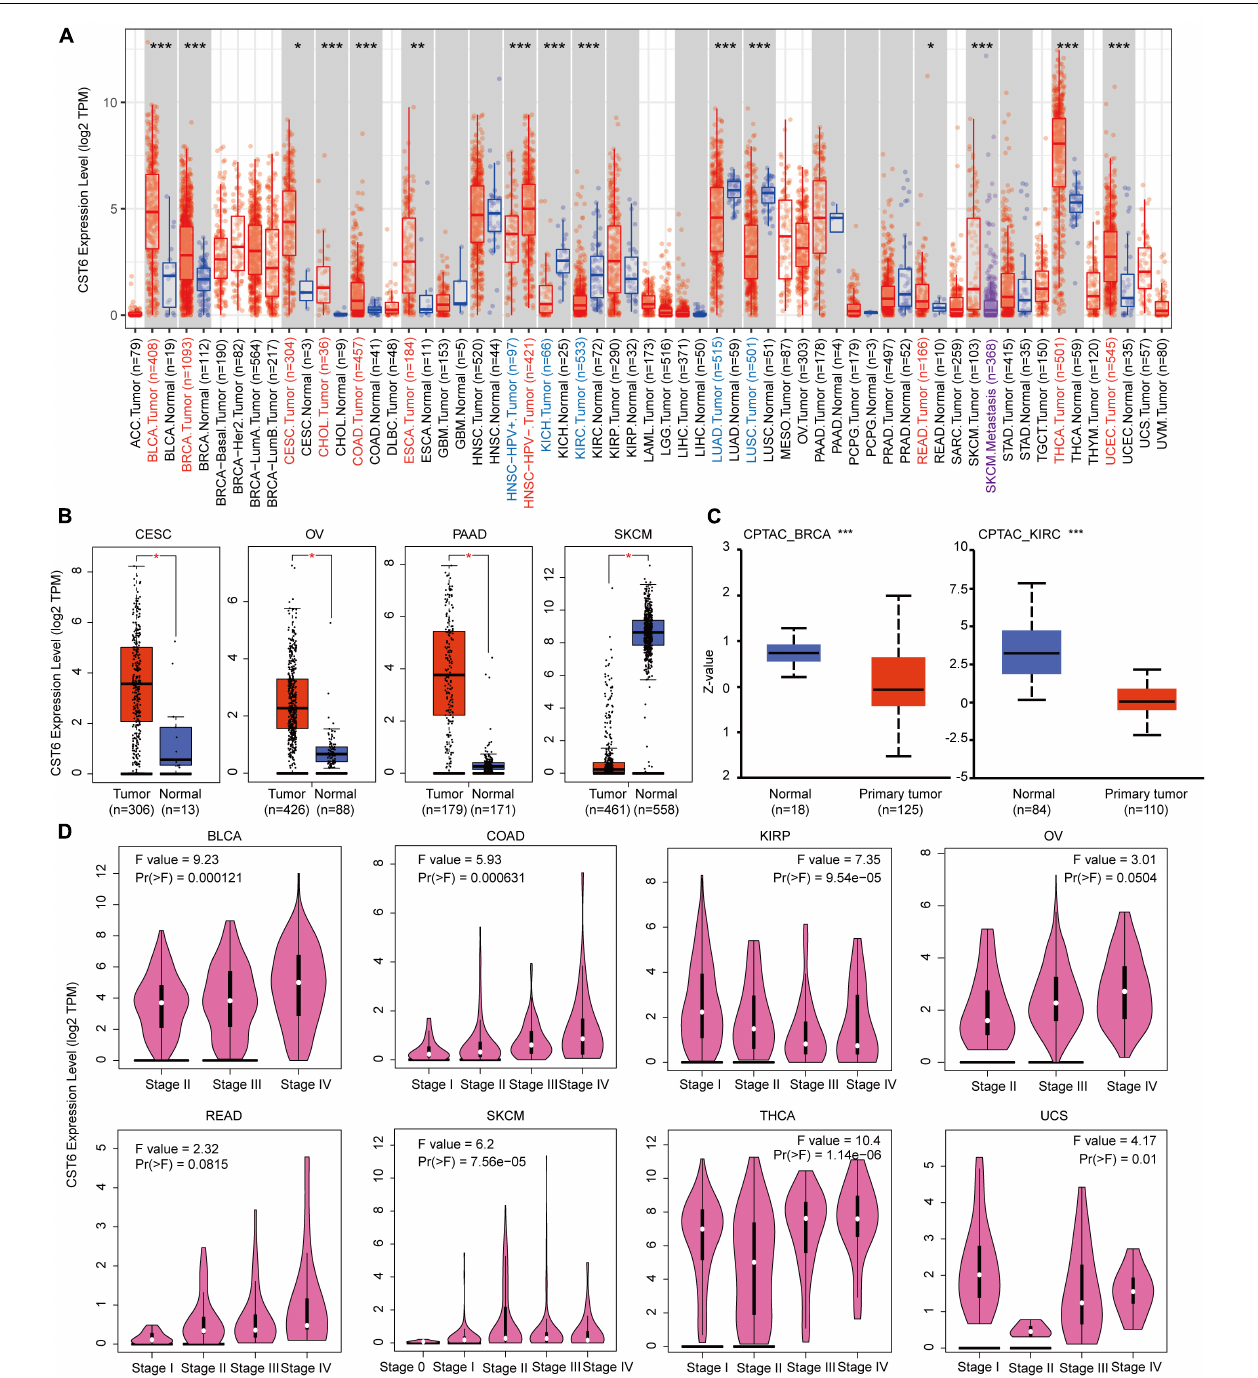
FIGURE 1 | Expression level of cystatin E/M (CST6) in different cancer types and pathological stages. (A) The expression level of CST6 in different cancer types from The Cancer Genome Atlas datasets. * p < 0.05; ** p < 0.01; *** p < 0.001. The symbol with red represents upregulated, and the symbol with blue represents downregulated. (B) The expression level of CST6 in cervical and endocervical cancer (CESC), ovarian serous cystadenocarcinoma (OV), pancreatic adenocarcinoma (PAAD), and skin cutaneous melanoma (SKCM). The corresponding normal samples of the GTEx datasets were included. (C) The expression level of CST6 total protein for breast invasive carcinoma (BRCA) and kidney clear cell carcinoma (KIRC) cancer types in the CPTAC dataset. (D) The expression level of CST6 was associated with the pathological stages of bladder urothelial carcinoma (BLCA), colon adenocarcinoma (COAD), kidney papillary cell carcinoma (KIRP), OV, rectum adenocarcinoma (READ), SKCM, thyroid carcinoma (THCA), and uterine carcinosarcoma (UCS) cancer types.